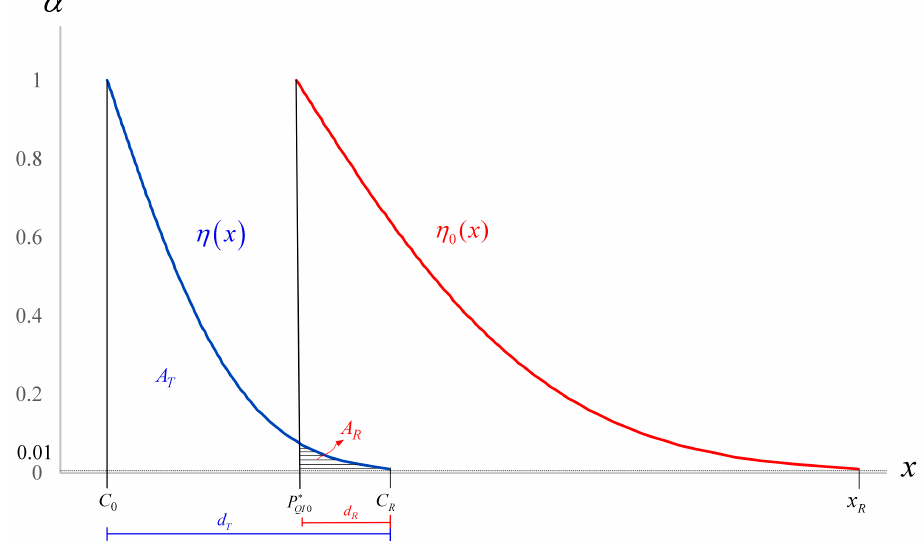
( ) x  . Figure 2. Diagram of membership functions η ( x ) and η ( x ) 0 0